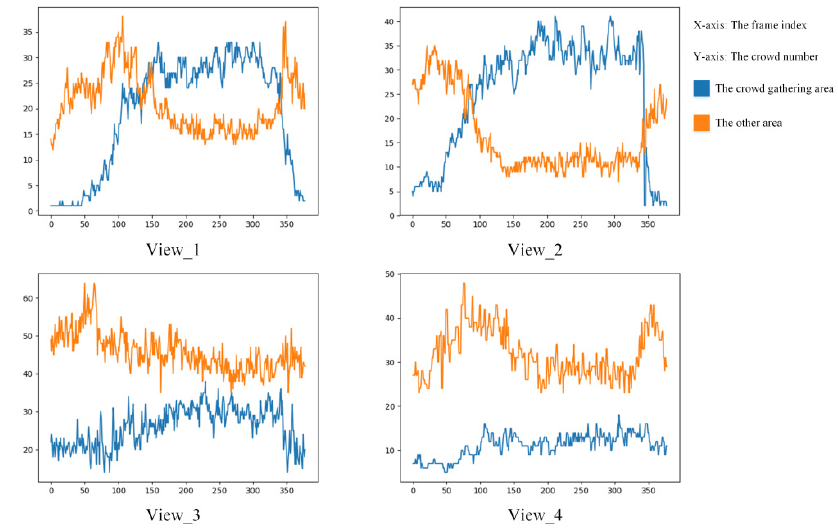
Figure 6. The curves of crowd gathering areas and other areas in four views. The blue curve denotes the crowd gathering area and the orange curve denotes the other areas.